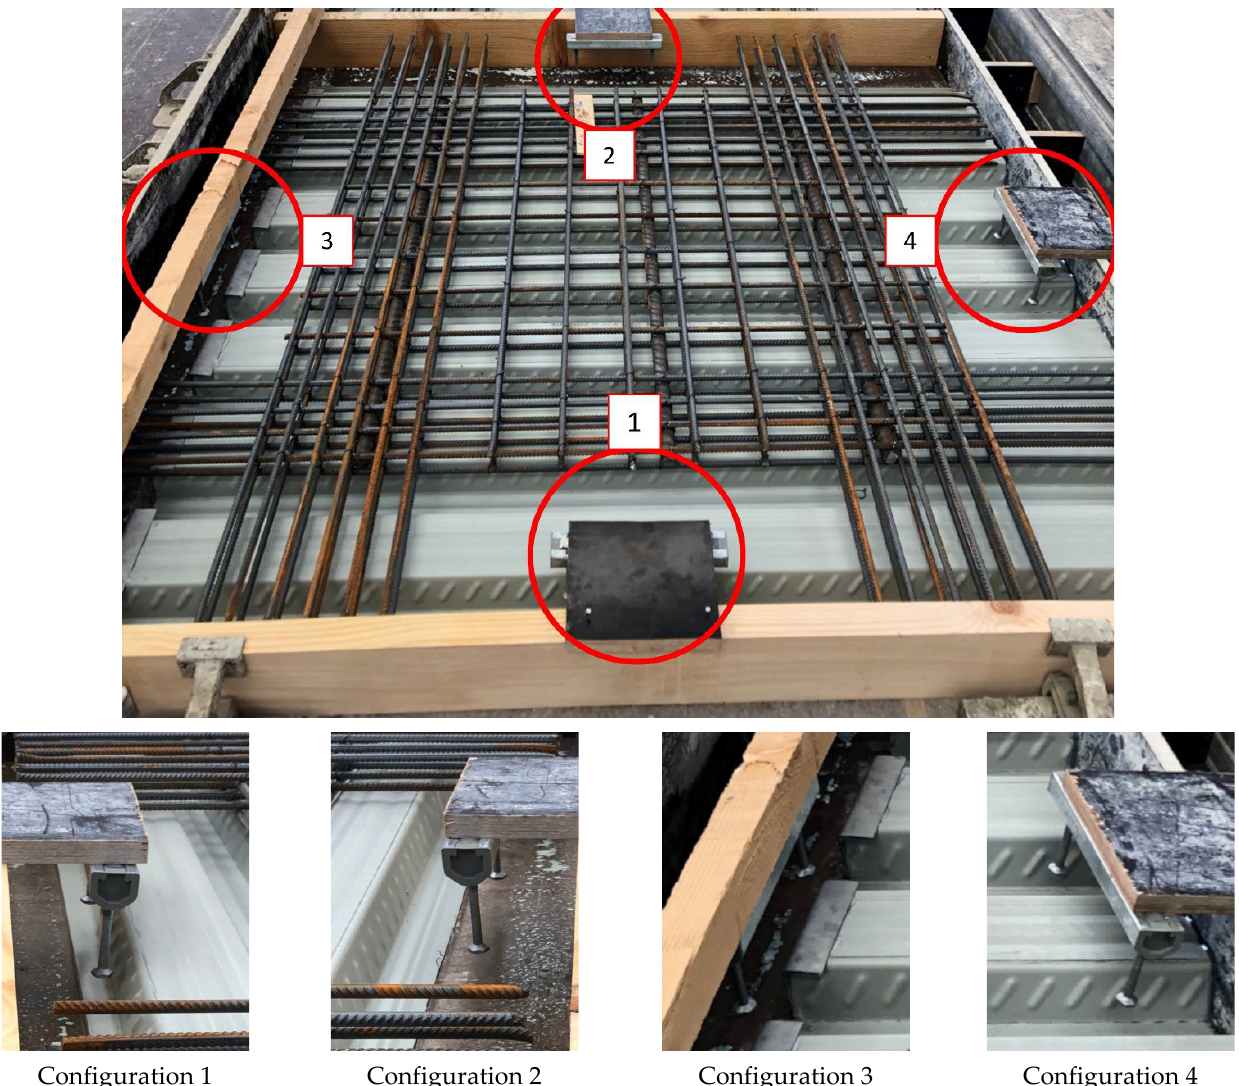
Figure 13. Composite slab layout.